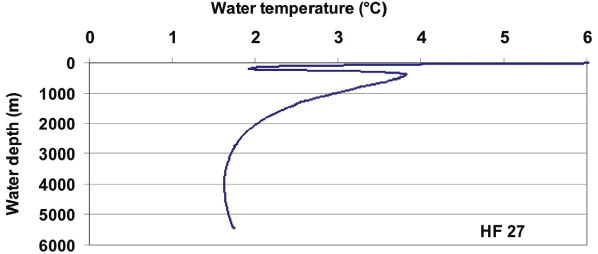
Fig. 4. An atypical increase of seawater temperatures – shown here for HF27 – was observed at three sites below ∼ 3800m, whose cause is unknown. The observed temperature inversion is not believed to adversely affect the heat flow